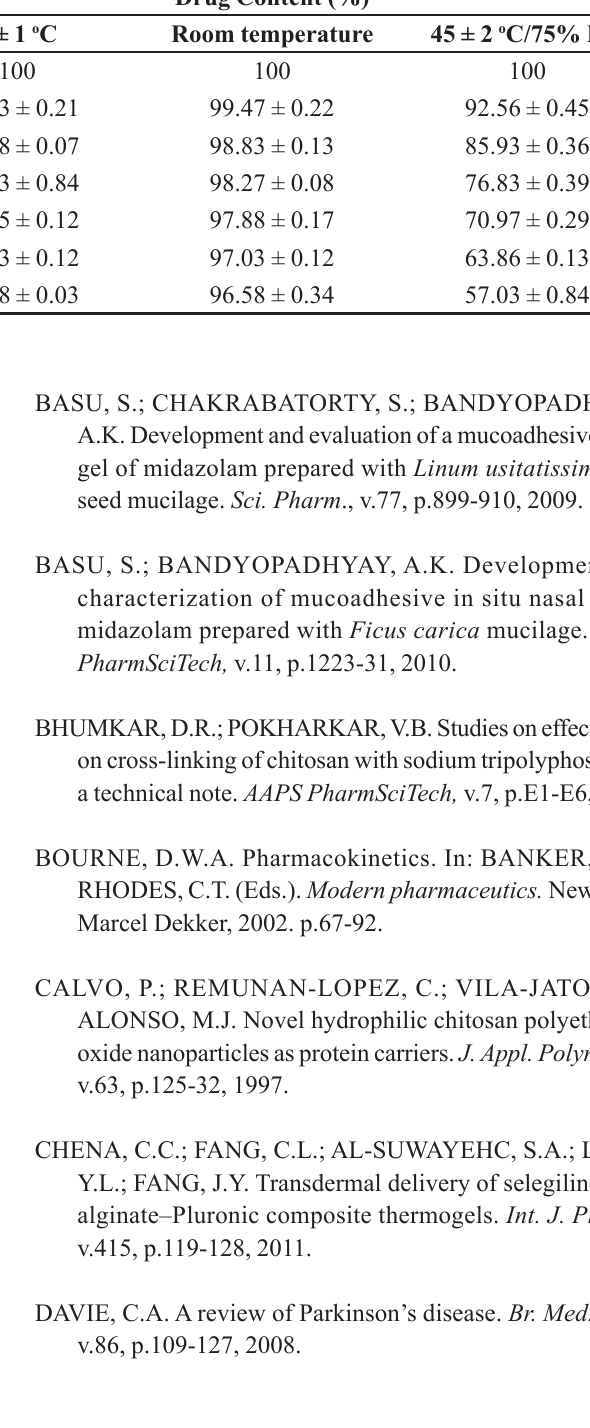
TABLE V - Stability studies of optimized formulation SHP4 S.